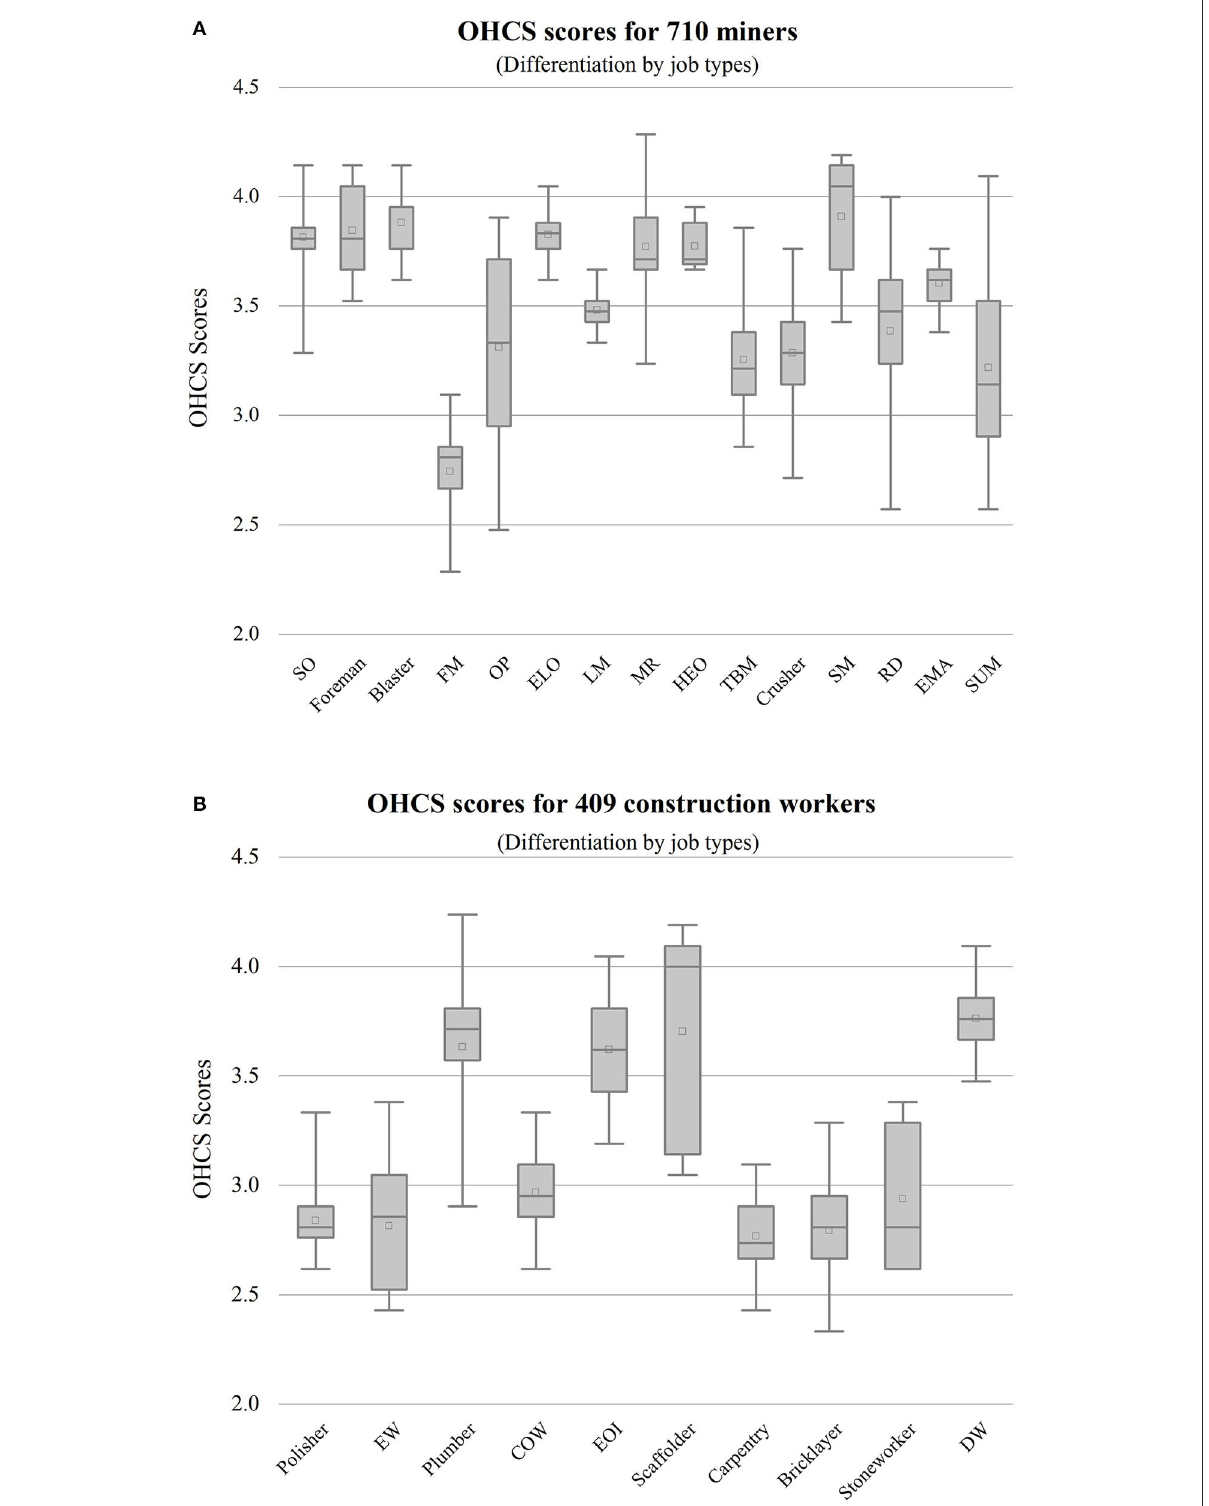
FIGURE5 (A) OHCS score distribution of miners. SO, safety officer; FM, filling worker; OP, ore porter; ELO, electric locomotive operator; LM, loading miners; MR, machine repairer; HEO, hoist engine operator; TBM, transport belt miner; SM, signaling miner; RD, rock driller; EMA, explosive magazine administrator; SUM, support miner. (B) OHCS score distribution of construction workers. EW, electric welder; COW, concrete worker; EOI, equipment installer; DW, decoration